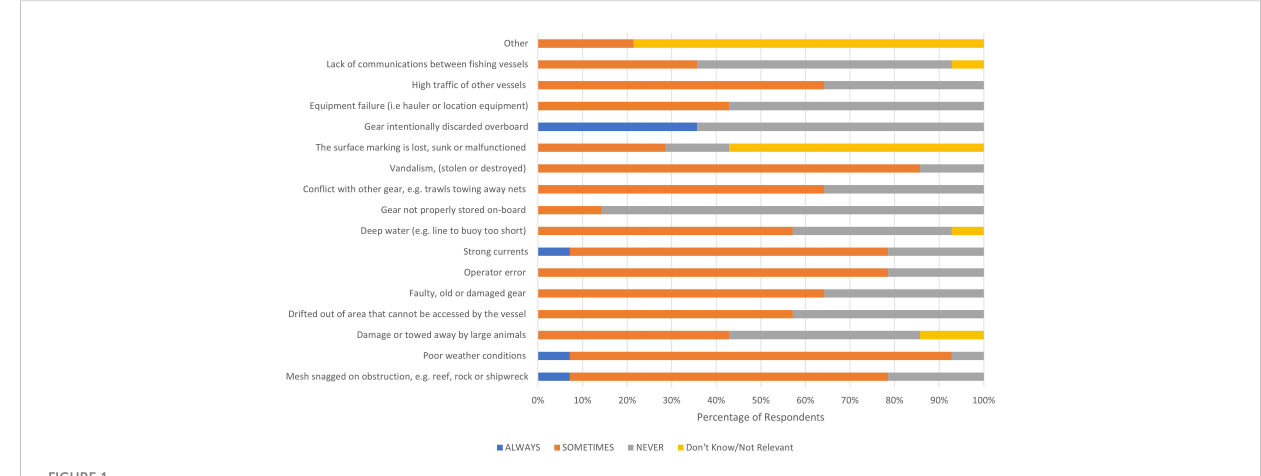
FIGURE 1 Summary of survey results from Antigua and Barbuda to the question: “ When a vessel loses traps, what are the main causes of the gear loss and their corresponding frequency of occurrence? ” (n =